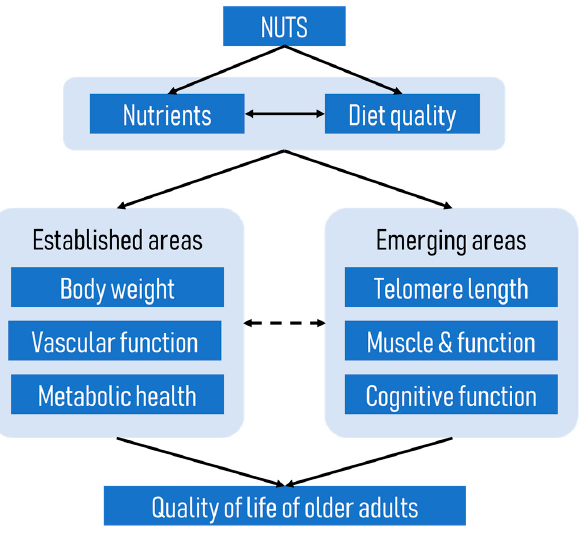
Figure 1. A conceptual framework of how nuts improve the quality of life of older